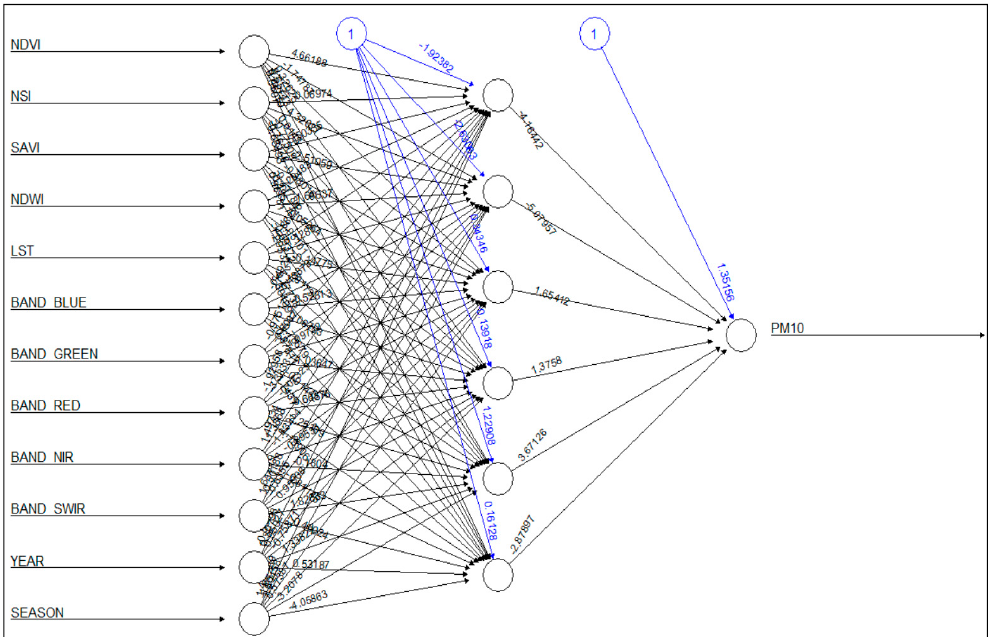
Figure 4. MLP diagram for Landsat-8 data.